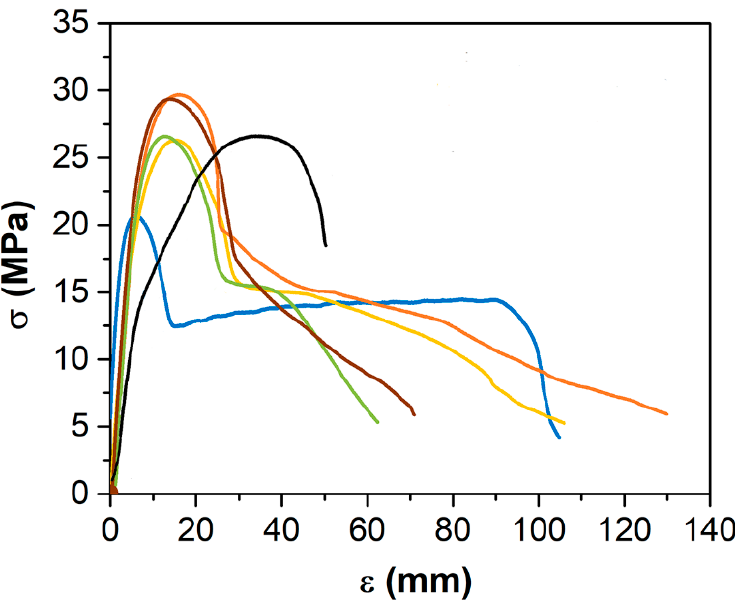
Figure 6. Effect of the recycling and the addition of Cu-NPs and Cu-NCs on the thermogravimetry of ( ) HDPE, ( ) HDPE 0.5 wt.% Cu-NPs, ( ) HDPE 0.7 wt.% Cu-NCs, ( ) rHDPE, ( ) rHDPE 0.5 wt.% Cu-NPs, and ( ) rHDPE 0.7 wt.% Cu-NCs. ( a ) TGA analysis and ( b ) max- imum thermal degradation rate.